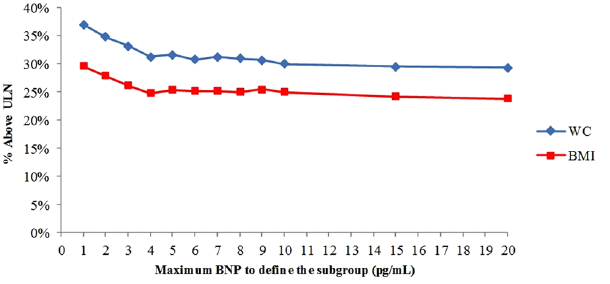
Figure 2. Percentage of subjects exceeding the ULN WC or BMI (Y-axis) in subgroups defined by maximum BNP levels (X-axis). BNP, B-type natriuretic peptide; WC, waist circumference; BMI, body mass index; ULN, upper limit of normal.